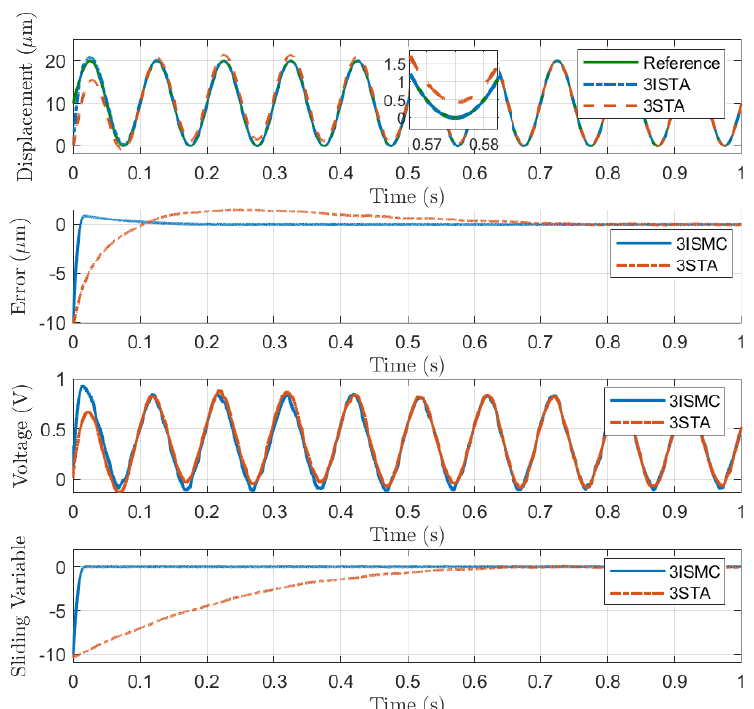
Figure 6. Simulation results of 10Hz sinusoidal trajectory tracking. ( a ) Position tracking results. ( b ) Position tracking error. ( c ) Control inputs. ( d ) Sliding